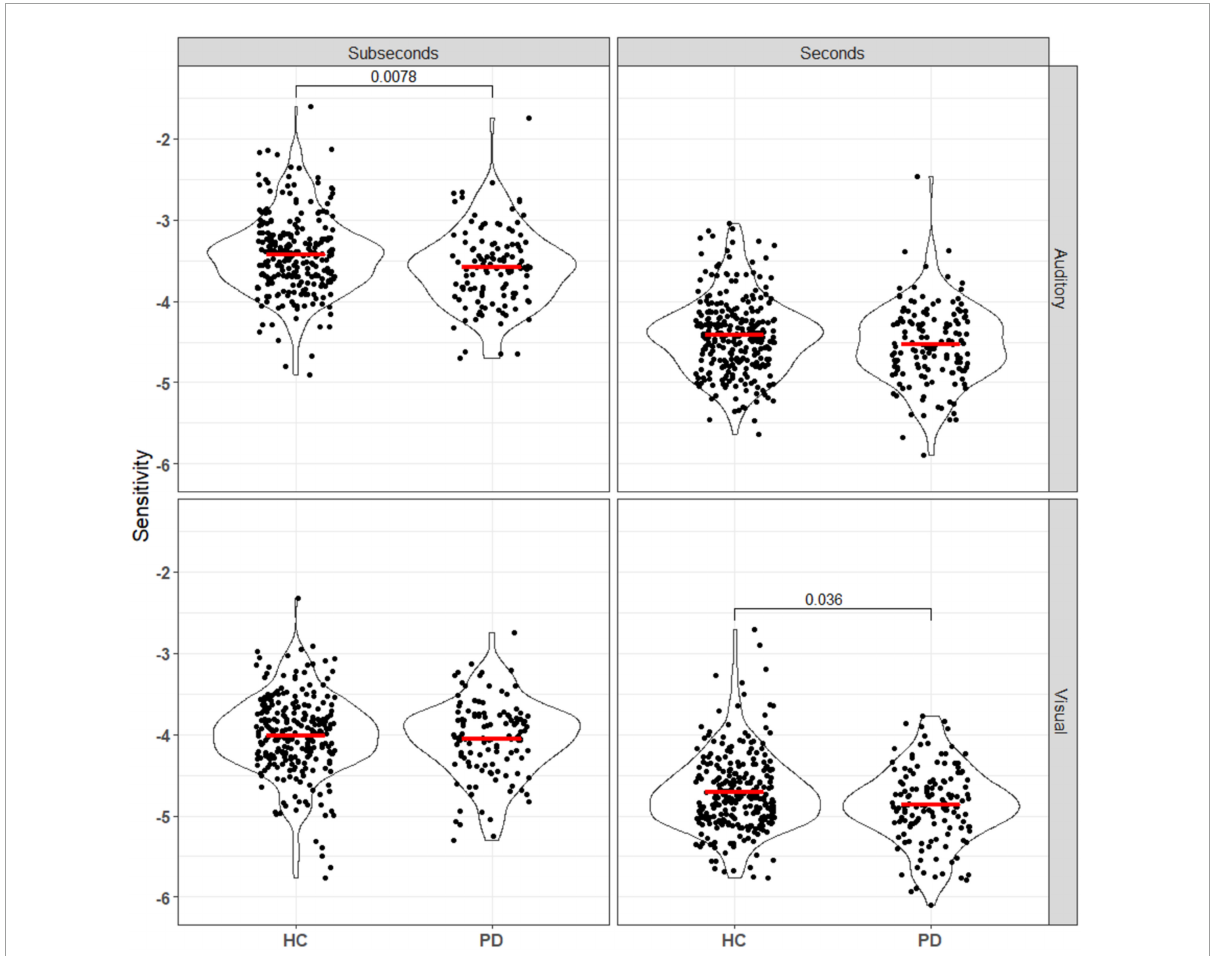
FIGURE3 Sensitivity, calculated using equation (Pouthas and Perbal, 2004), of all patients and controls to both auditory and visual stimuli in the seconds and subseconds intervals. PD patients showed impaired time perception to auditory stimuli in the subseconds range and visual stimuli in the seconds range. Annotations denote adjusted p -values after Bonferroni correction, only statistically significant p -values are